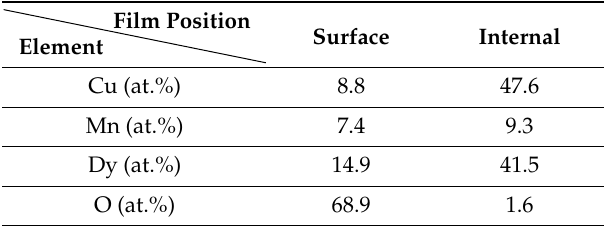
Table 2. Compositions of Cu–Mn films with 40 at.% Dy addition annealed at 300 ° C using electron spectroscopy for chemical analysis (ESCA). Film Element